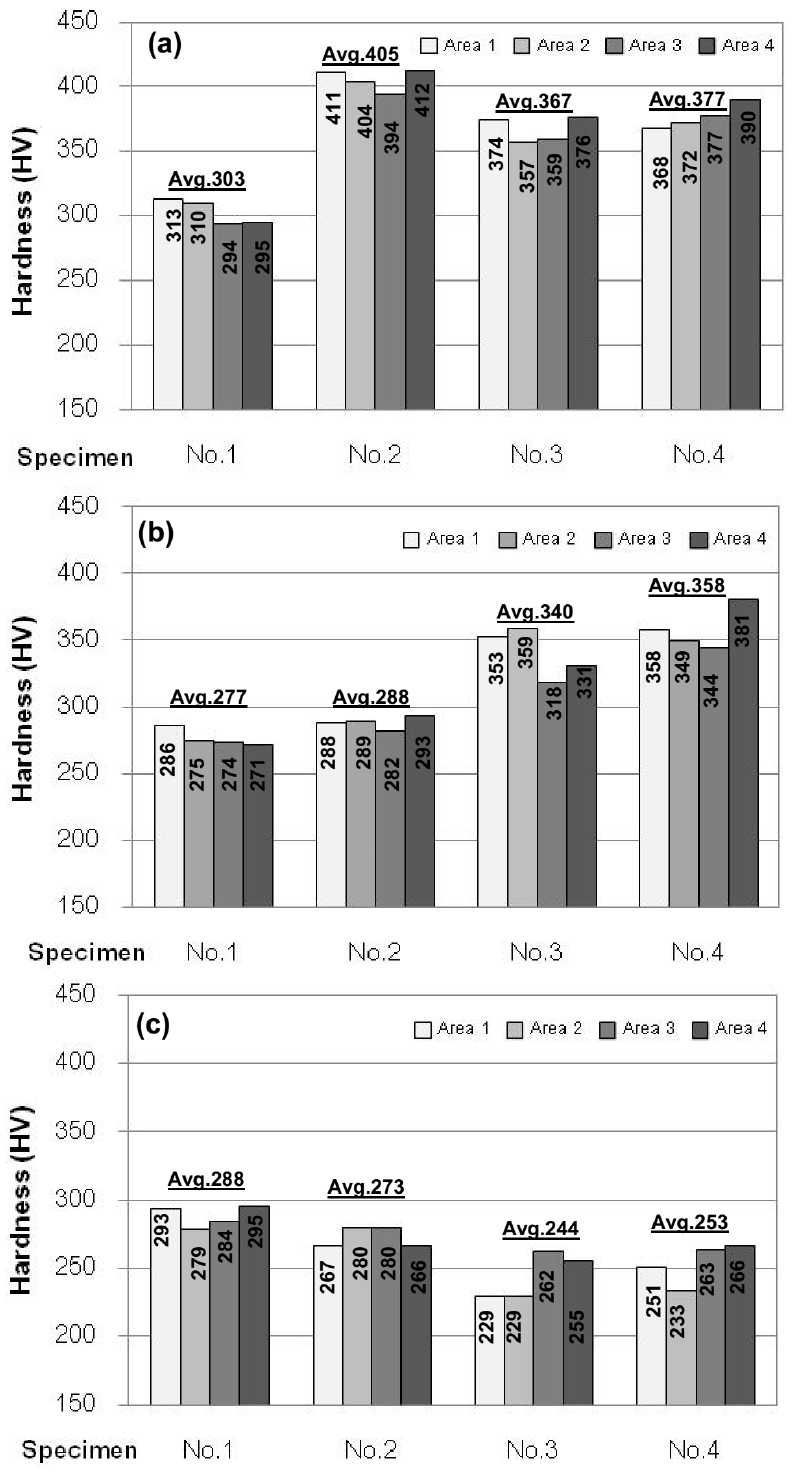
Figure 5. The hardness value of four areas in each specimen with different heat treatments: ( a ) without heat treatment; ( b ) 600 °C/1 h; and ( c ) 900 °C/1 h.